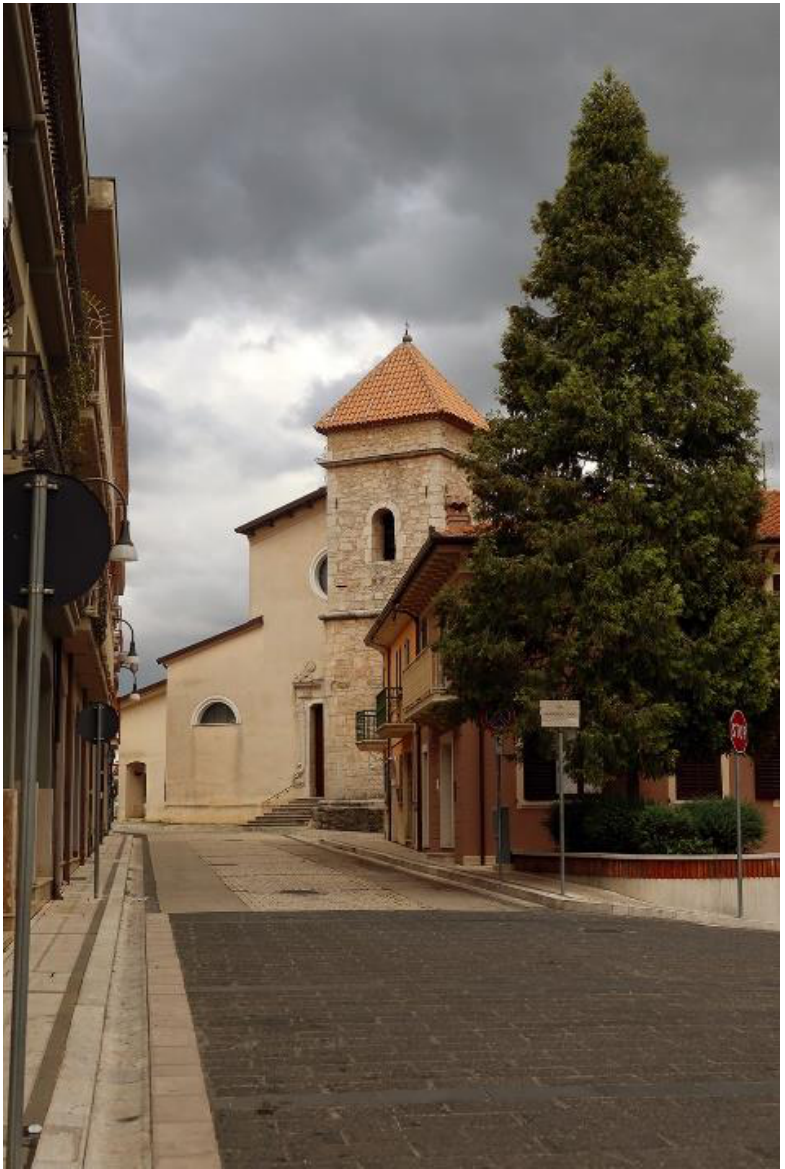
Figure 28. Lioni: restored Church and bell tower of S. Maria Assunta (photos by [35,36]).